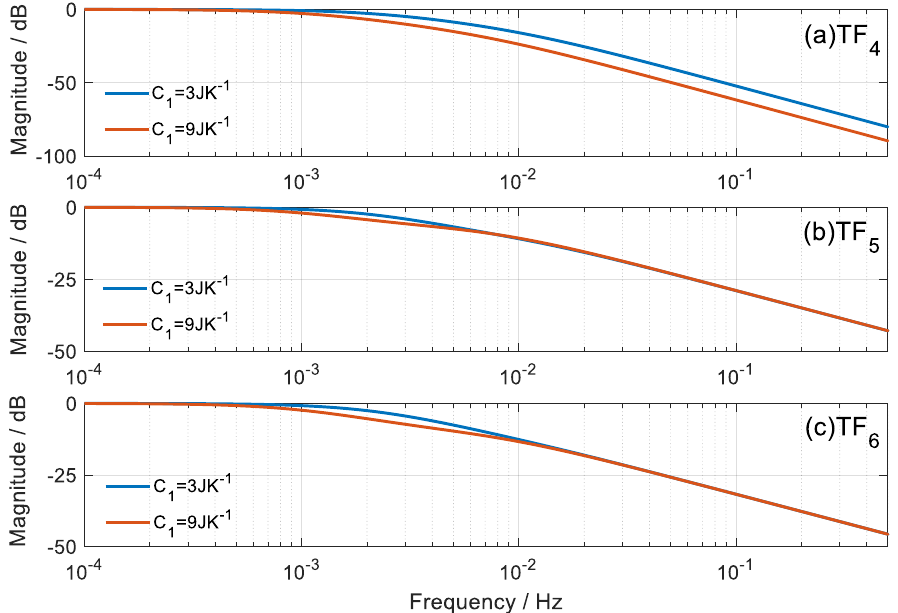
Figure 6. Bode representation of the magnitude of the TF i that relates the temperature of the thermostat with the inputs of the calorimetric system.